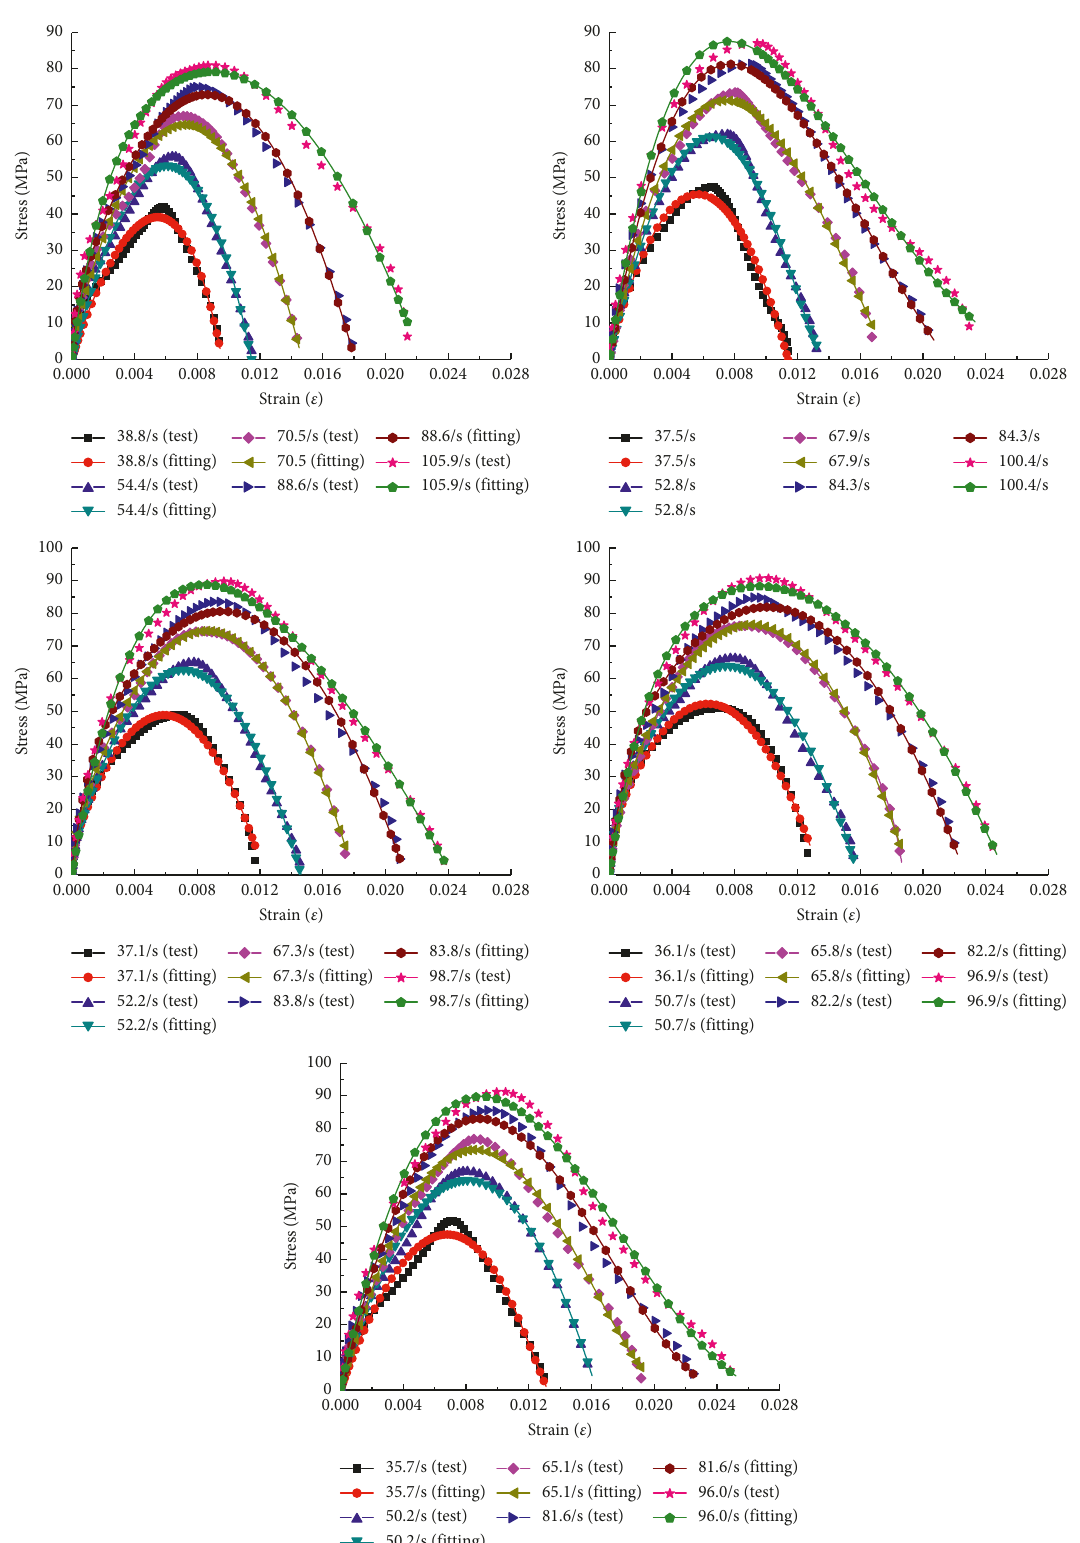
Figure 15: Comparison of the experimental values and the fitted values of each group of fiber